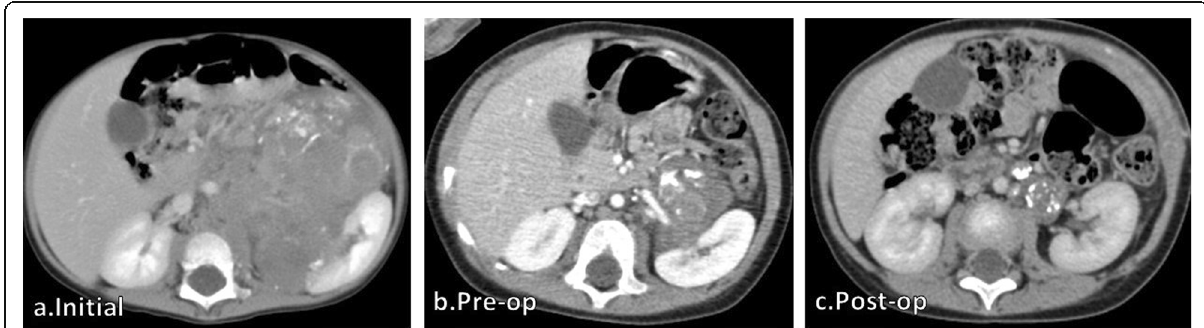
Fig. 5 A 2.5-year-old female. a Initial CT axial cut showing infiltrative neuroblastoma, encasing the aorta, invading the left renal pedicle, and infiltrating the left kidney. b Pre-operative CT axial cut showing regressive course of the mass lesion, still invading the left renal pedicle, and